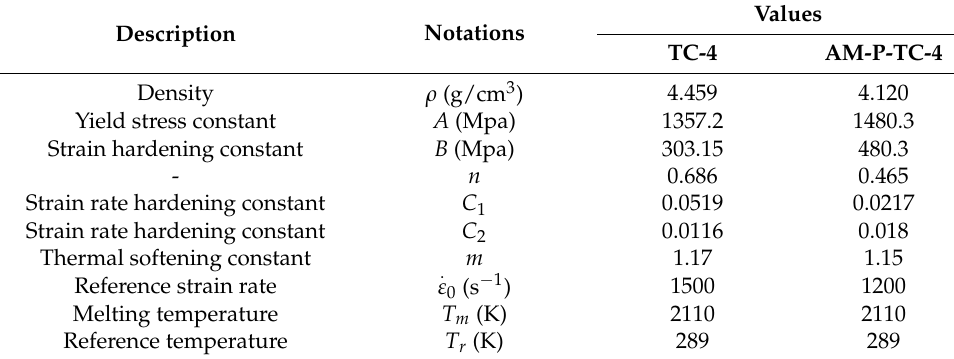
Table 3. Constitutive parameters.